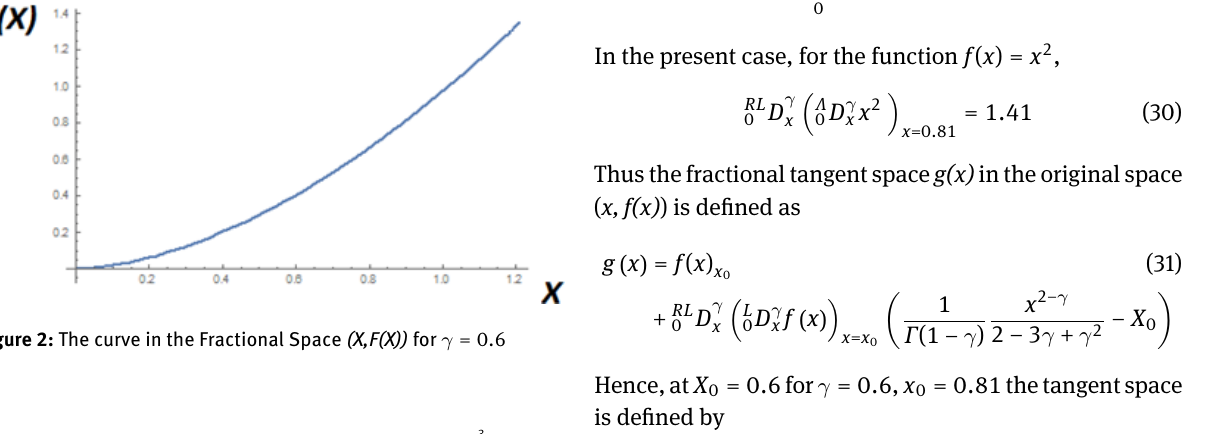
with M = (2 − 3 𝛾 + 𝛾 2 ) XΓ (1 − 𝛾 ).